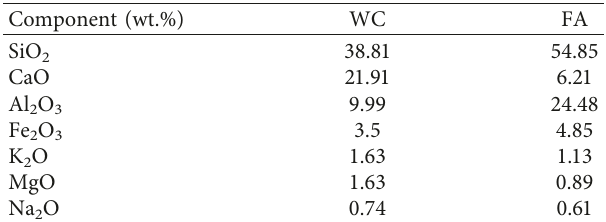
Table 1: Chemical components of WC and FA determined by XRF